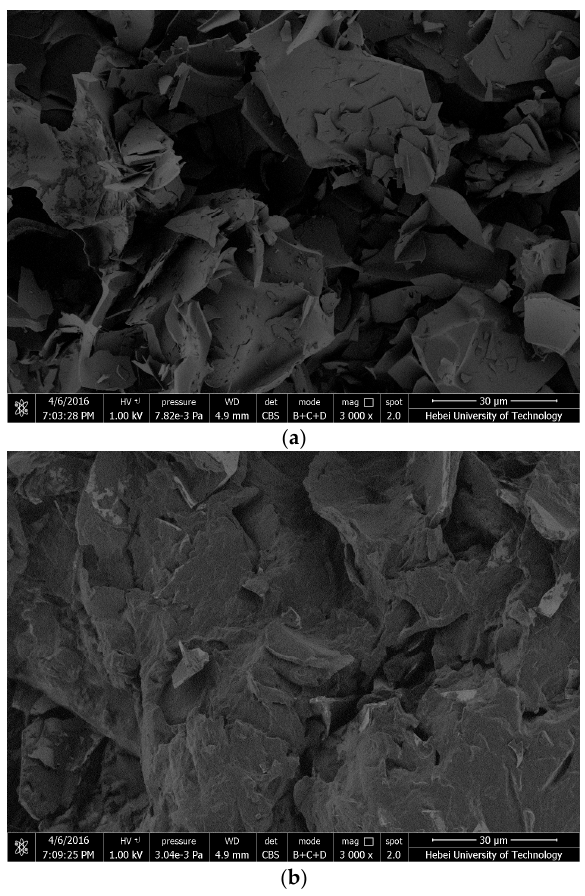
Figure 9. Morphological appearance of: EP ( a ); and TD-LA/EP ( b ).